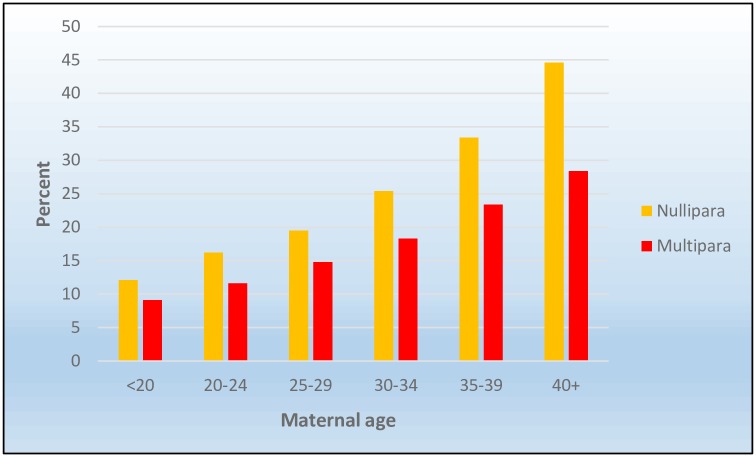
Unadjusted risk of cesarean section stratified by parity and age (years).